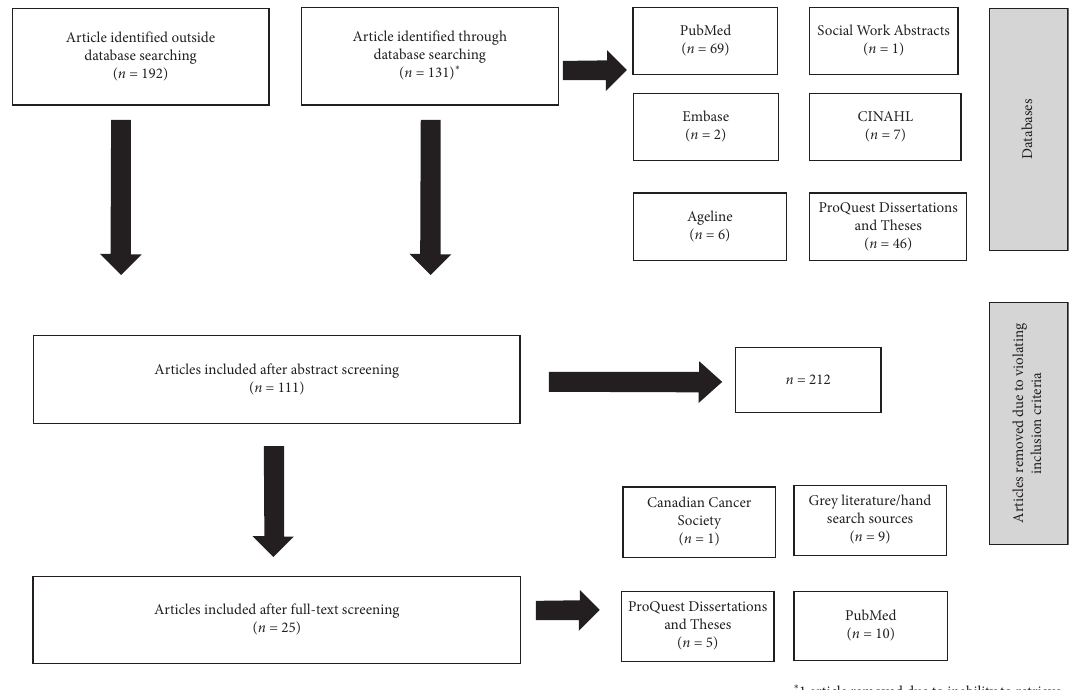
Figure 1: Search